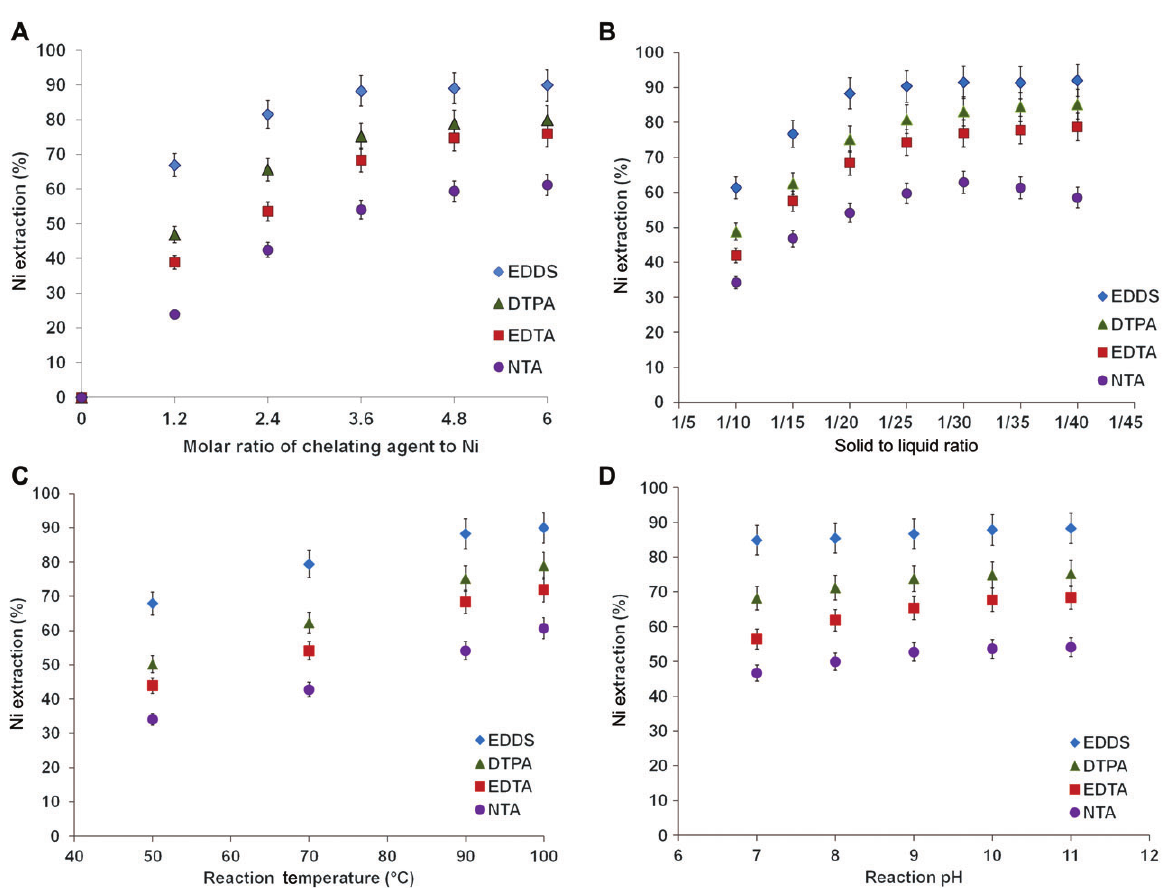
Figure 5 (A) Effect of molar ratio of chelating agent to Ni on (%) Ni extraction. (Reaction conditions: S/L = 1/20 g/ml, temperature = 90 ° C, pH = 11, reaction time = 8 h), (B) effect of solid to liquid ratio on (%) Ni extrac- tion. (Reaction conditions: MR = 3.6, temperature = 90 ° C, pH = 11, reaction time = 8 h), (C) effect of reaction temperature on (%) Ni extraction. (Reaction conditions: MR = 3.6, S/L = 1/20, pH = 11, reaction time = 8 h) and (D) effect of pH on (%) Ni extraction. (Reaction conditions: MR = 3.6, temperature = 90 ° C, S/L = 1/20, reaction time = 8